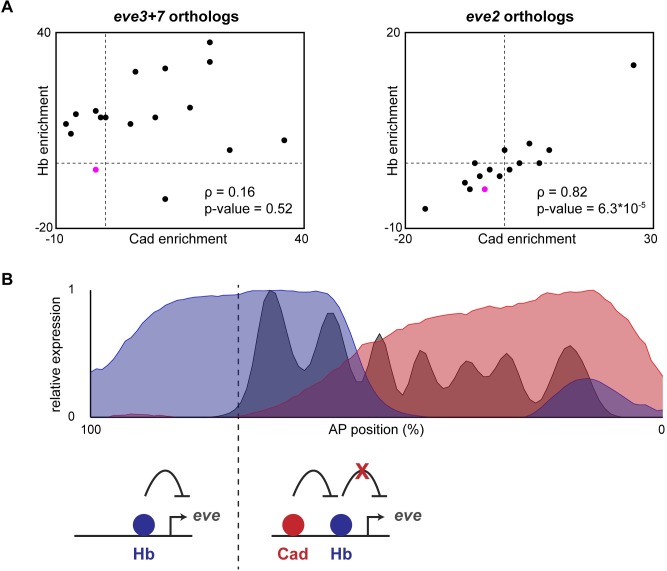
Caudal and Hunchback binding sites co-evolve in orthologous eve stripe 2 enhancers.(A) Enrichment scores for predicted Hb and Cad binding sites in orthologous eve stripe 2 and eve3+7 sequences from different Drosophilid and Sepsid species [51]. Scores were calculated by comparing the number of predicted sites to an expected value calculated from the genomic background [52]. Scores for Drosophila melanogaster enhancers are indicated in magenta. Spearman correlation and p-value are displayed for each set of enhancers. (B) Summary of current findings. Top: levels of Hb protein (blue), Cad protein (red) and Eve protein (grey) are plotted as a function of anterior-posterior position. Data were taken from the FlyEx database [75]. Bottom: cartoon indicating Hb function in eve2+7 at different locations in the embryo. In the anterior, Cad levels are low, so Hb represses eve2+7. In the trunk, Cad binding to eve2+7 prevents Hb repression.